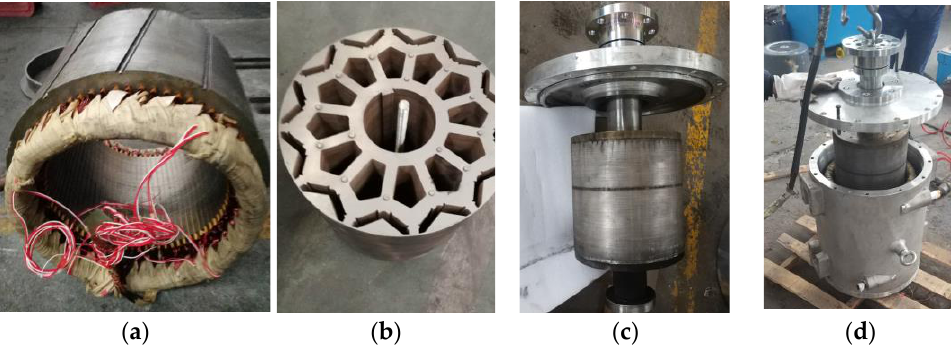
Figure 8. Machine components. ( a ) Stator assembly. ( b ) Rotor core. ( c ) Rotor assembly. ( d ) Machine assembly.